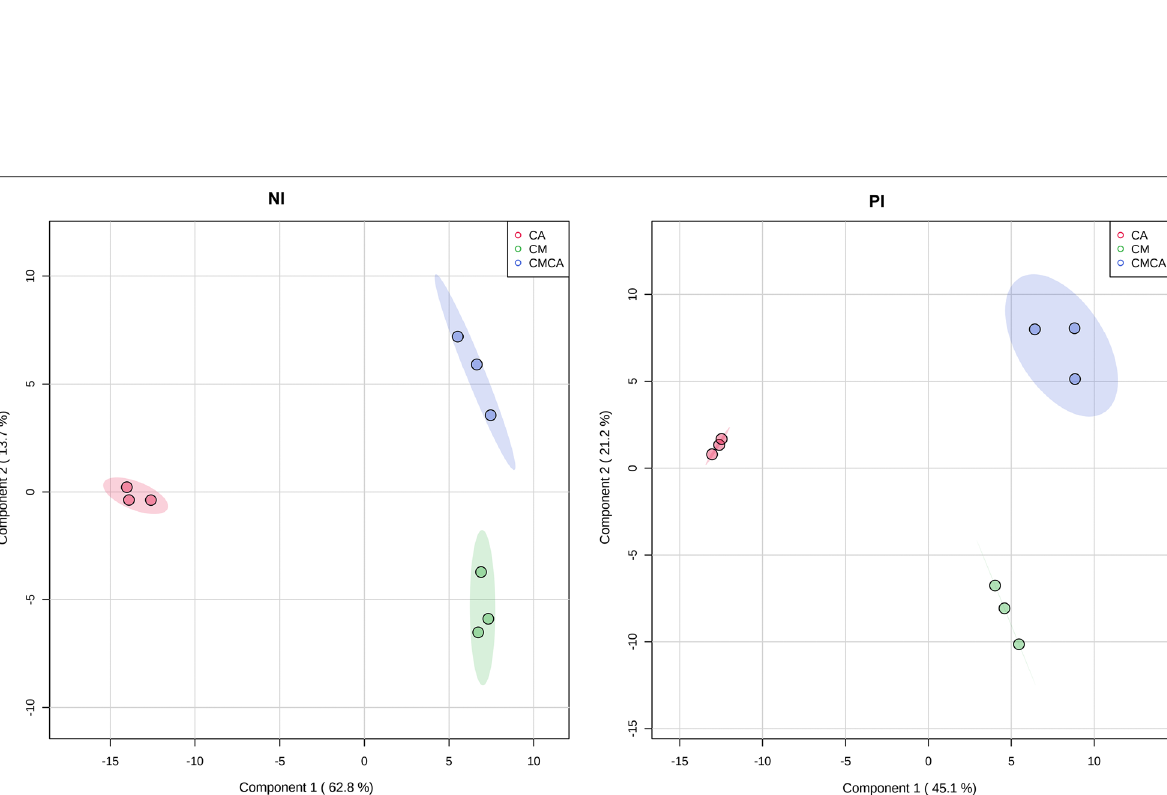
Fig. 3 PLS-DA score plots of fungal cultures based on ESI levels). CM: Cophinforma mamane ; CA: Candida albicans , CMCA: co-culture of CM and